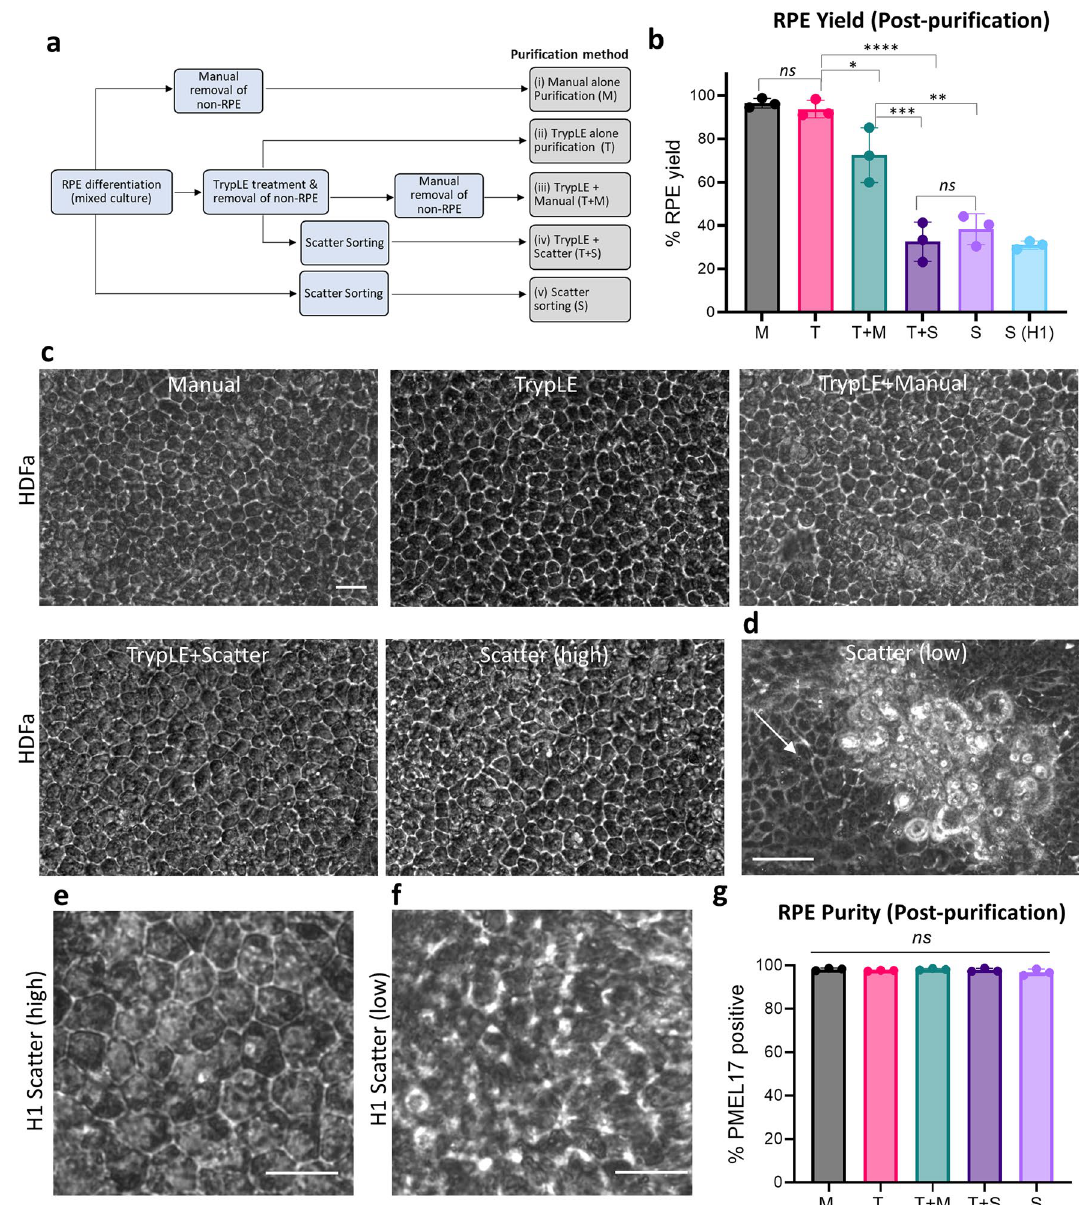
Figure 3. Comparison different RPE purification methods for yield and purity. ( a ) Overview of steps involved in the five different RPE purification methods. ( b ) HDFa- RPE yield of the different purification methods. S (H1): RPE cells from H1 differentiation cultures purified by scatter sorting. ( c ) Purified HDFa-RPE from all five methods were cultured for 6 weeks and showed typical polygonal morphology. Scale bar, 20 μm. ( d ) Cells obtained from scatter low fraction post-sorting showed clusters of non-RPE cells, and polygonal RPE cells (white arrow). Scale bar, 50 μm. ( e and f ) 6 weeks old cultured H1-RPE cells obtained from ( e ) scatter high and ( f ) low fractions of H1 (ESC) differentiation cultures. Scale bar, 20 μm. ( g ) Purity of cells obtained by different methods assessed by PMEL17 flow cytometry after 6 weeks in culture. Statistical analysis for ( b ) and ( g ) done using one-way ANOVA, followed by Tukey’s honest significance difference (HSD) post hoc test. ns , not significant, (*) = p < 0.05; (**) = p < 0.005, (***) = p < 0.0005, (****) = p <